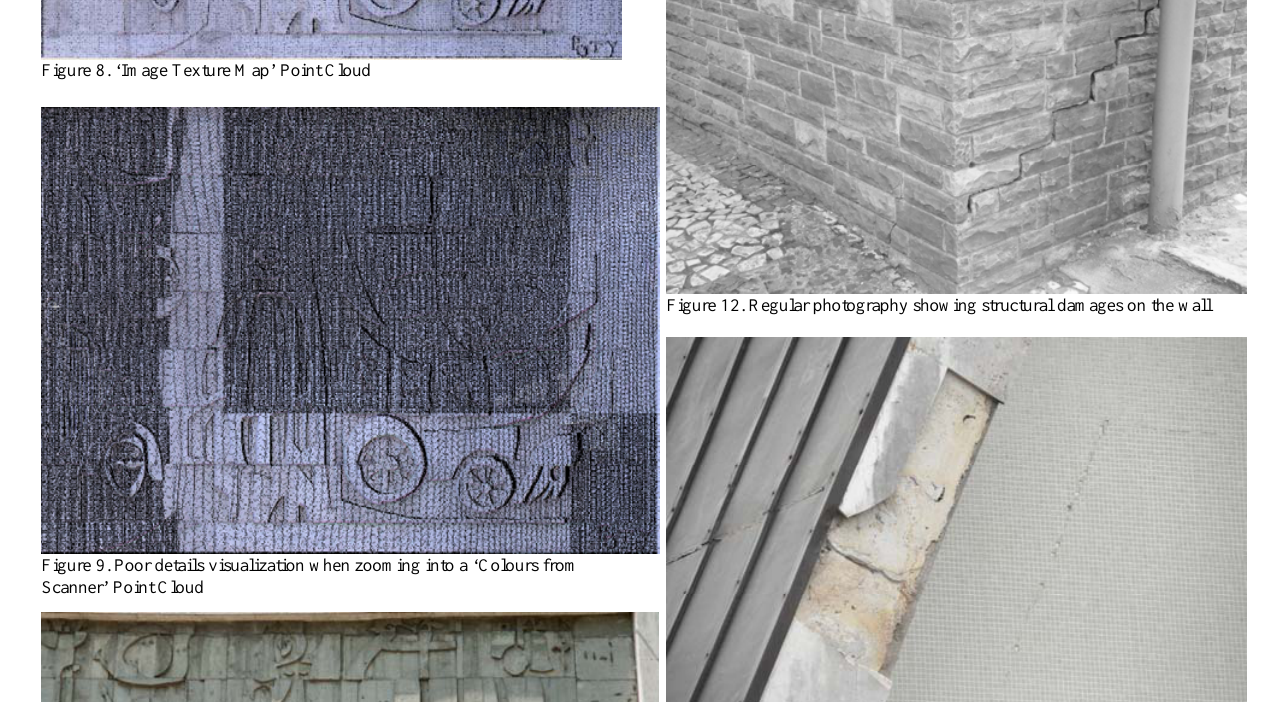
Figure 13. Regular photography from structural damages and missing or broken marble